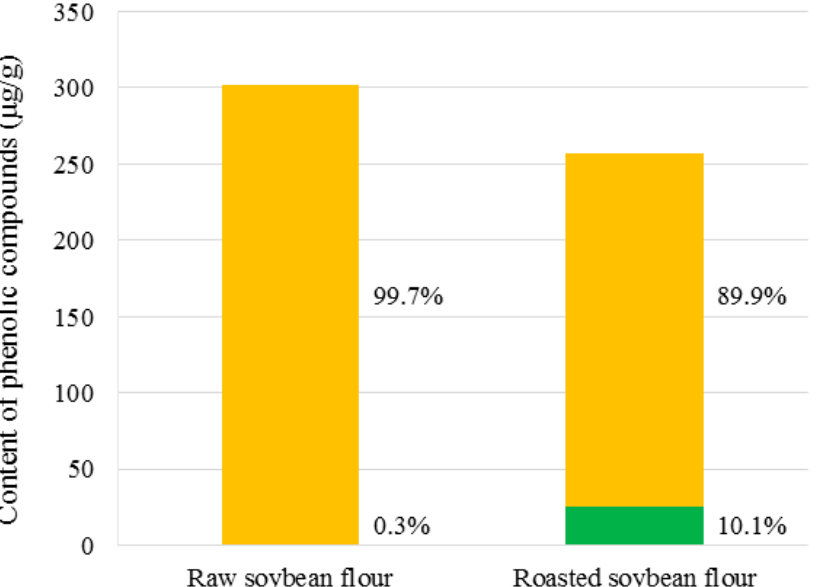
Figure 3. Composition of the PC in RWSF and RSF.